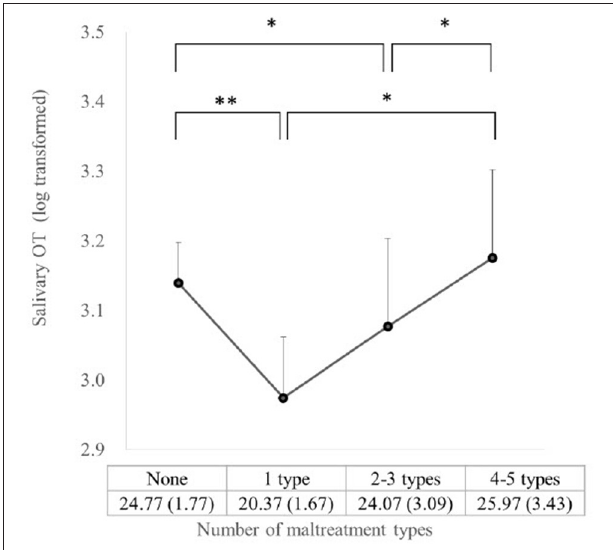
FIGURE 1 | Salivary OT for number of maltreatment types (* P < 0.10, ** P < 0.05). The mean (SD) of the raw OT values for each category of maltreatment type number is presented for graph